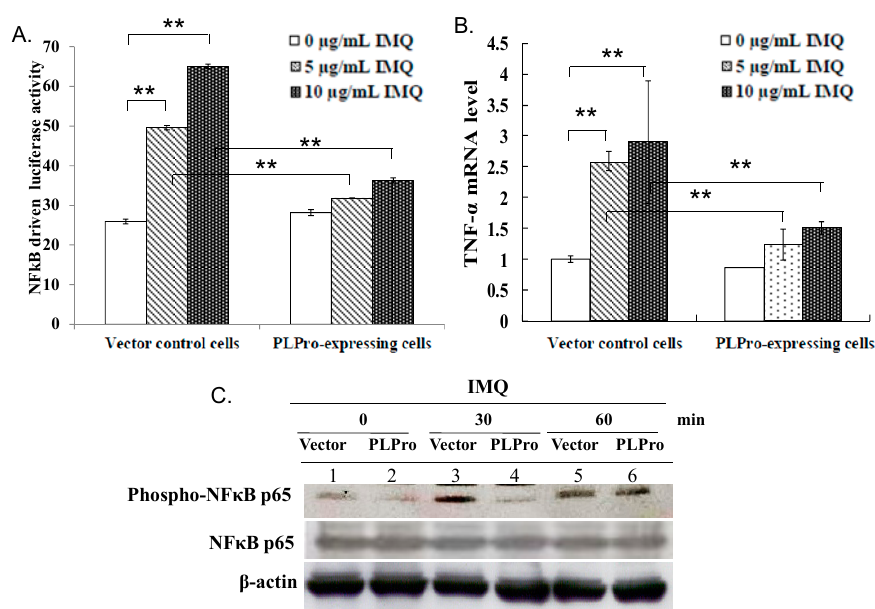
Figure 3. Inhibition of IMQ-induced TNF- α production via NF- κ B signaling by SARS-CoV PLPro. Both types of cells were treated with(out) IMQ for 4 h, and then, NF- κ B-driven luciferase reporter activity and the TNF- α mRNA level were determined using the dual luciferase reporter assay ( A ) and quantitative PCR ( B ), respectively. For determining NF- κ B activation, the lysates were also analyzed using Western blot with anti-phospho-NF- κ B p65 antibodies ( C ). ** p -Value < 0.01 by Student’s t -test.